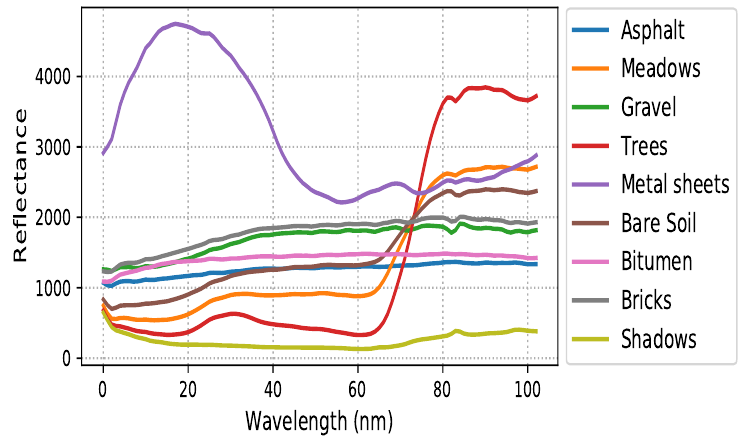
Figure 3. Land cover category of Indian Pines dataset.